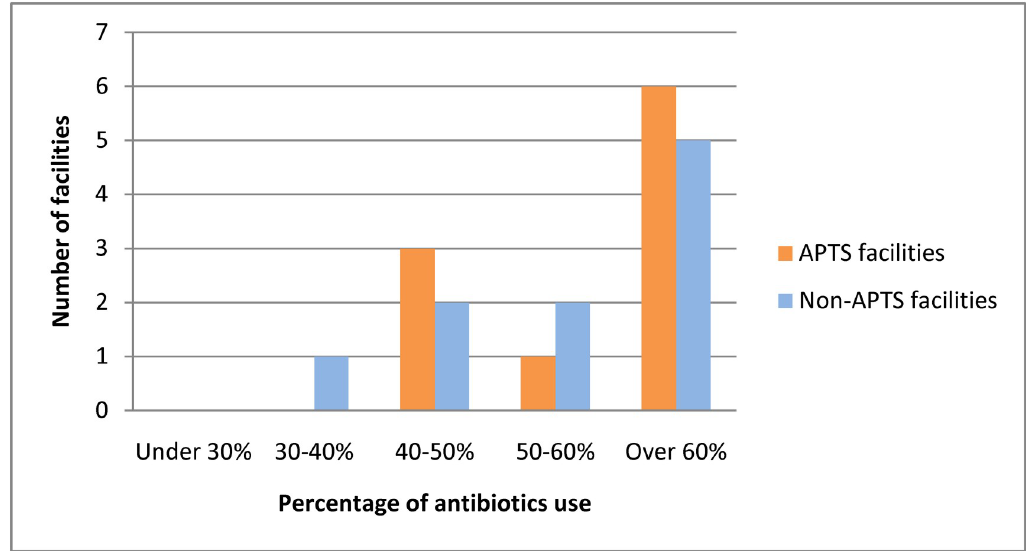
Fig 7. Percentage of antibiotics use between APTS and Non-APTS facilities.